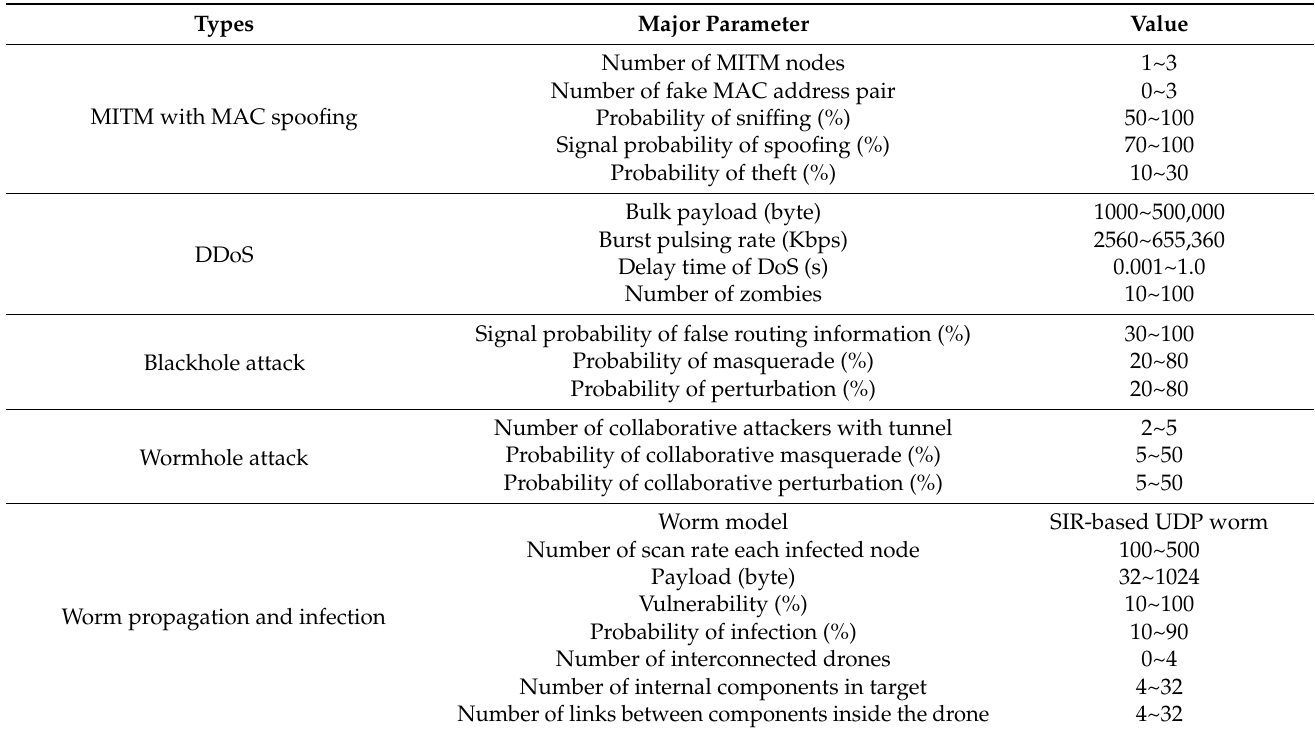
Table 3. D-CEWS (DEVS-based cyber-electronic warfare)-based communication and functional simulation parameters for MITM, spoofing, DDoS, hole-based routing attack, and network worm with cyber warfare